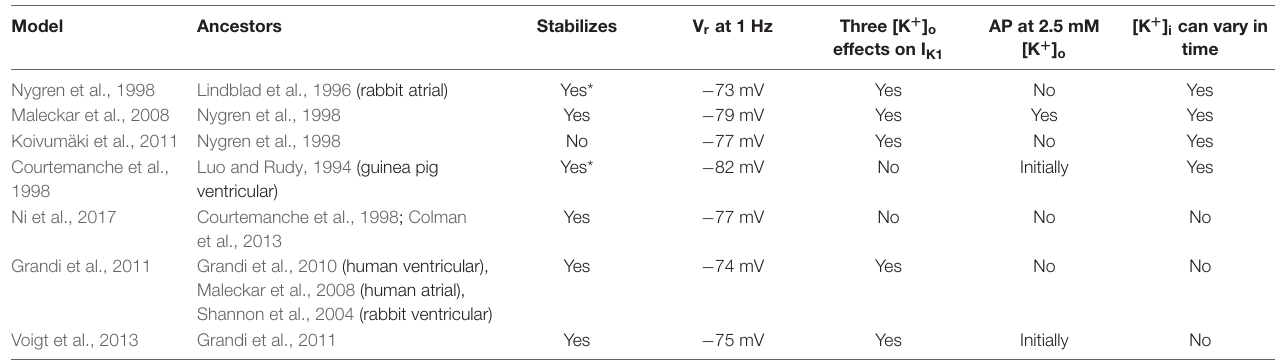
TABLE 1 | Summary of the mathematical models of the human atrial action potential and resting potential that form the basis of this study.